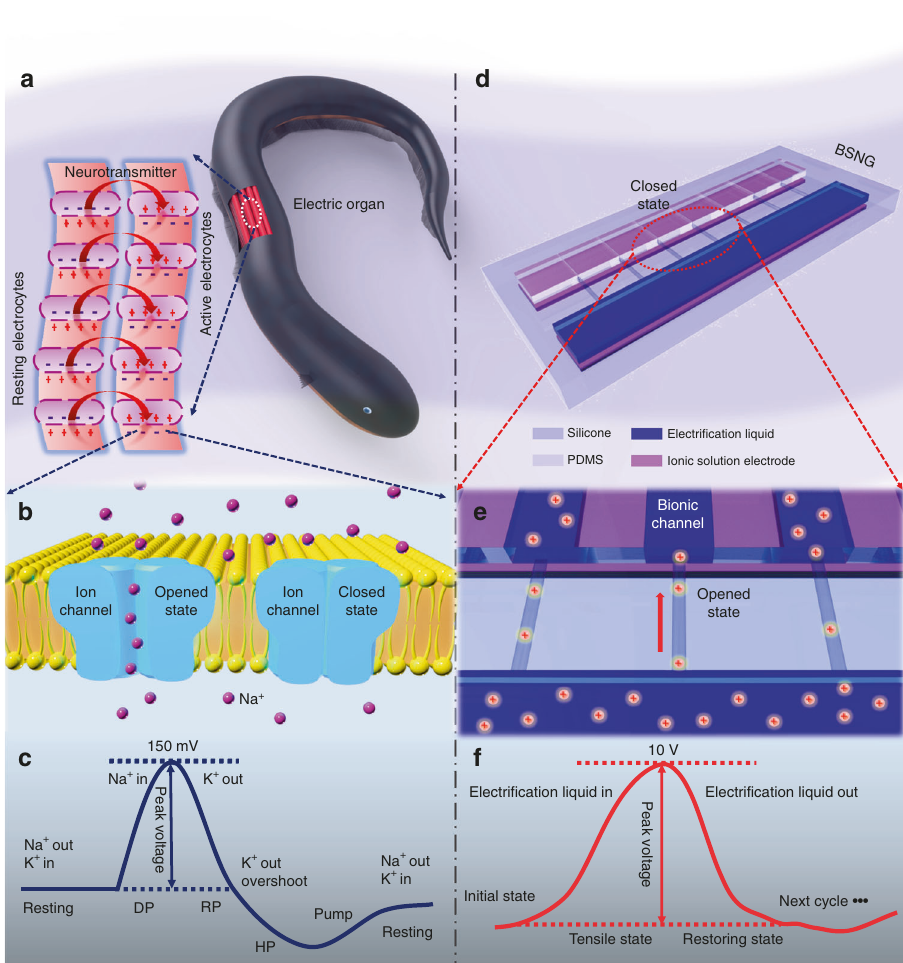
Fig. 1 Bionic principle and structure of bionic stretchable nanogenerator. a Schematic diagram of electric eel and electrocytes. b Schematic diagram of ion channels on cytomembrane. c Action potential signal of electrocyte. DP, RP, and HP represent depolarization, repolarization, and hyperpolarization, respectively. d Scheme diagram of bionic stretchable nanogenerator (BSNG) with double layer structure, which is mainly constructed by silicone, polydimethylsiloxane (PDMS), electri fi cation liquid and ionic solution electrode. e Scheme diagram of the bionic channels in BSNG. f Output signal of BSNG in one working